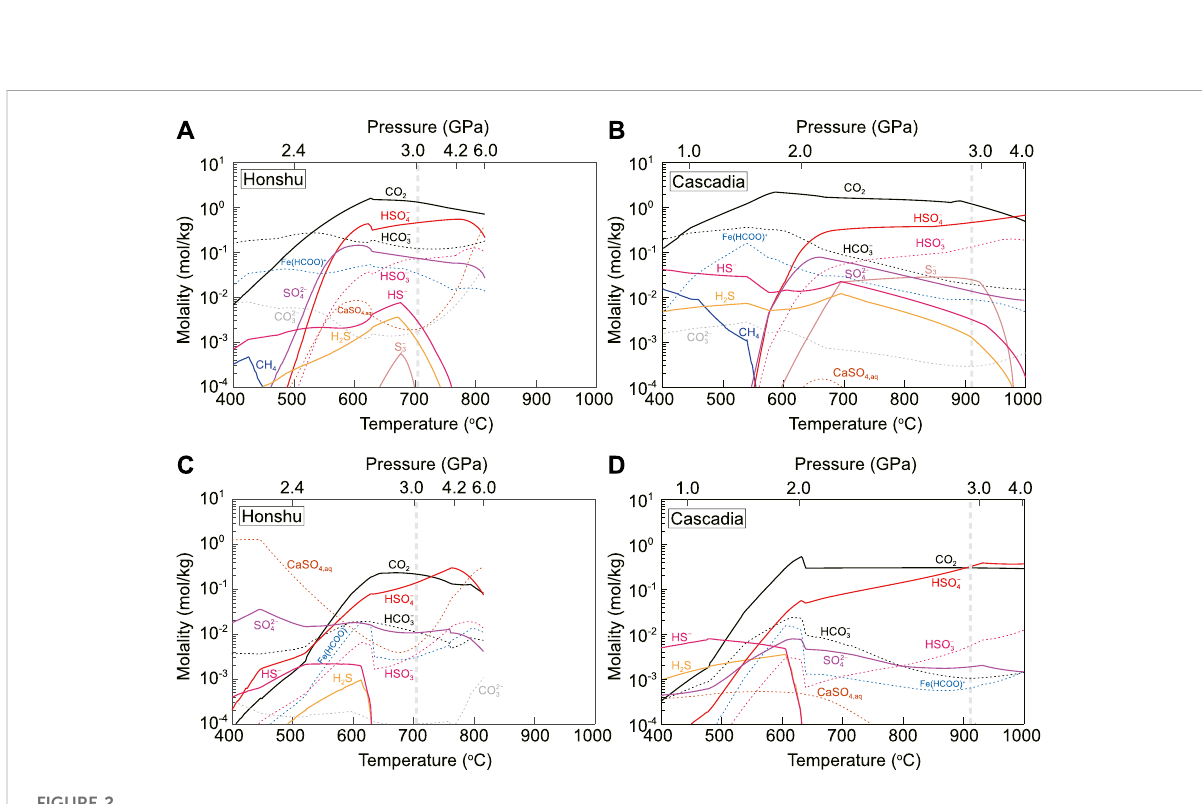
FIGURE 2 Concentrations of redox-sensitive carbon and sulfur species in the AOC (A, B) - and serpentinite (C, D) -derived fl uids along the Honshu and Cascadia subduction geotherms in the closed system. These results are almost equal to those in the open system (Supplementary Figure S4). The dashed thick line marks the subarc depths, geometrically constrained by Syracuse et al.